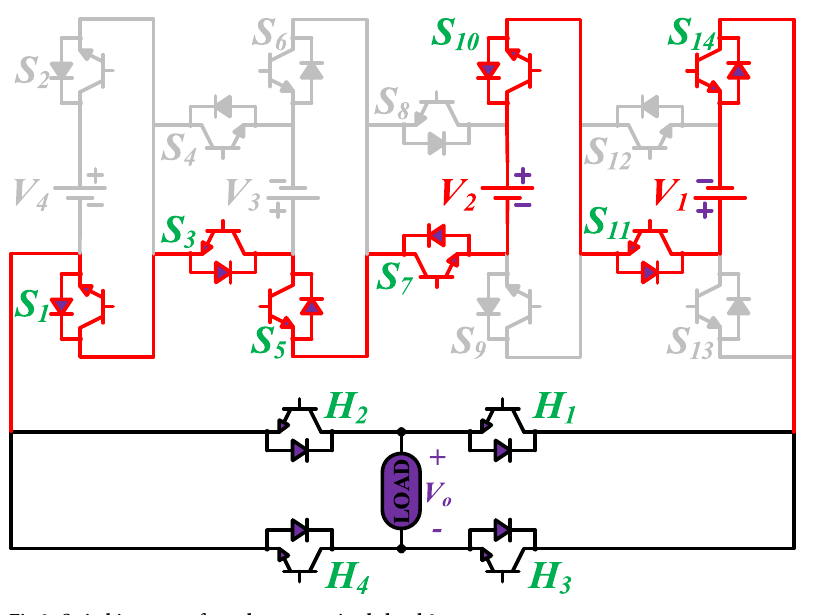
Fig 3. Switching states for voltage magnitude level 2.